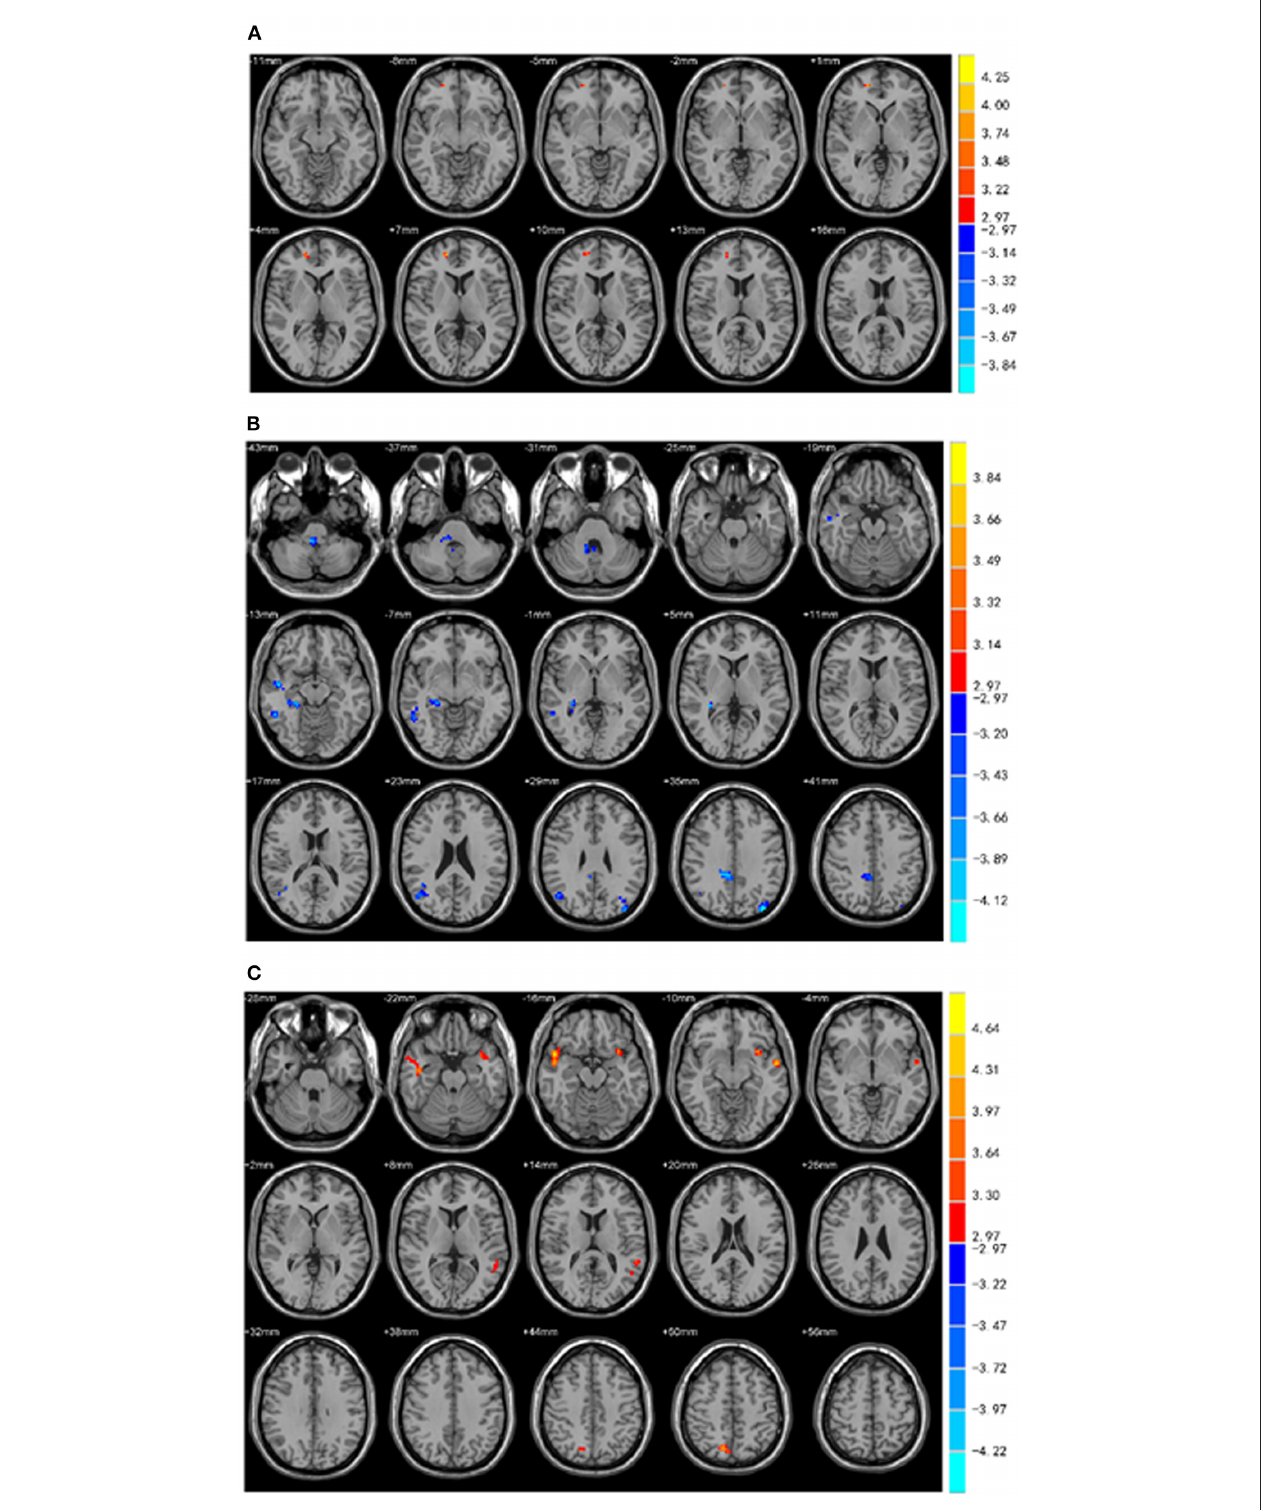
FIGURE 3 | Functional connectivity analysis. (A) Using right putamen as the seed point, the FC of the right medial frontal gyrus in the PD-EDS group was increased compared with the PD-NEDS group (red area in the figure) ( P < 0.05, after AlphaSim correction). (B) With the right anterior cingulate gyrus as the seed point, the FC